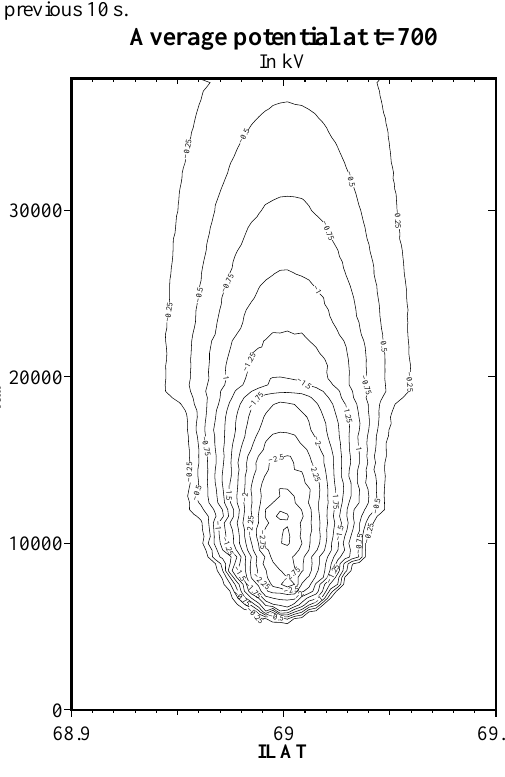
Fig. 6. Electric potential at t = 700s, averaged over the previous